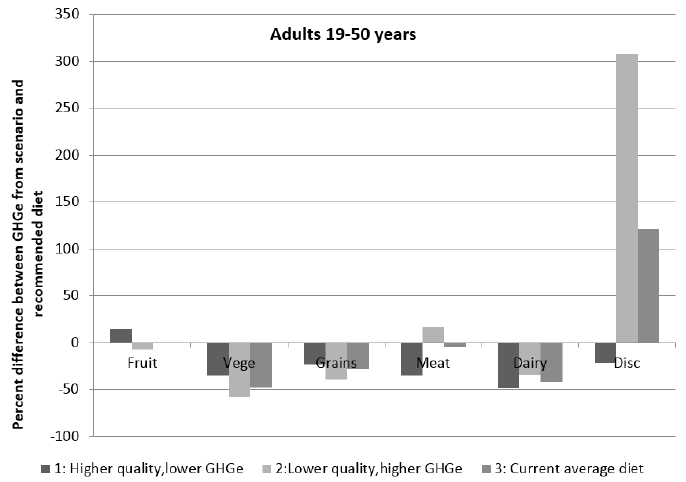
Figure 4. Difference between greenhouse gas emissions from the current average dietary patterns and the recommended daily diet as a percentage of the recommended intake for adults aged 19–50